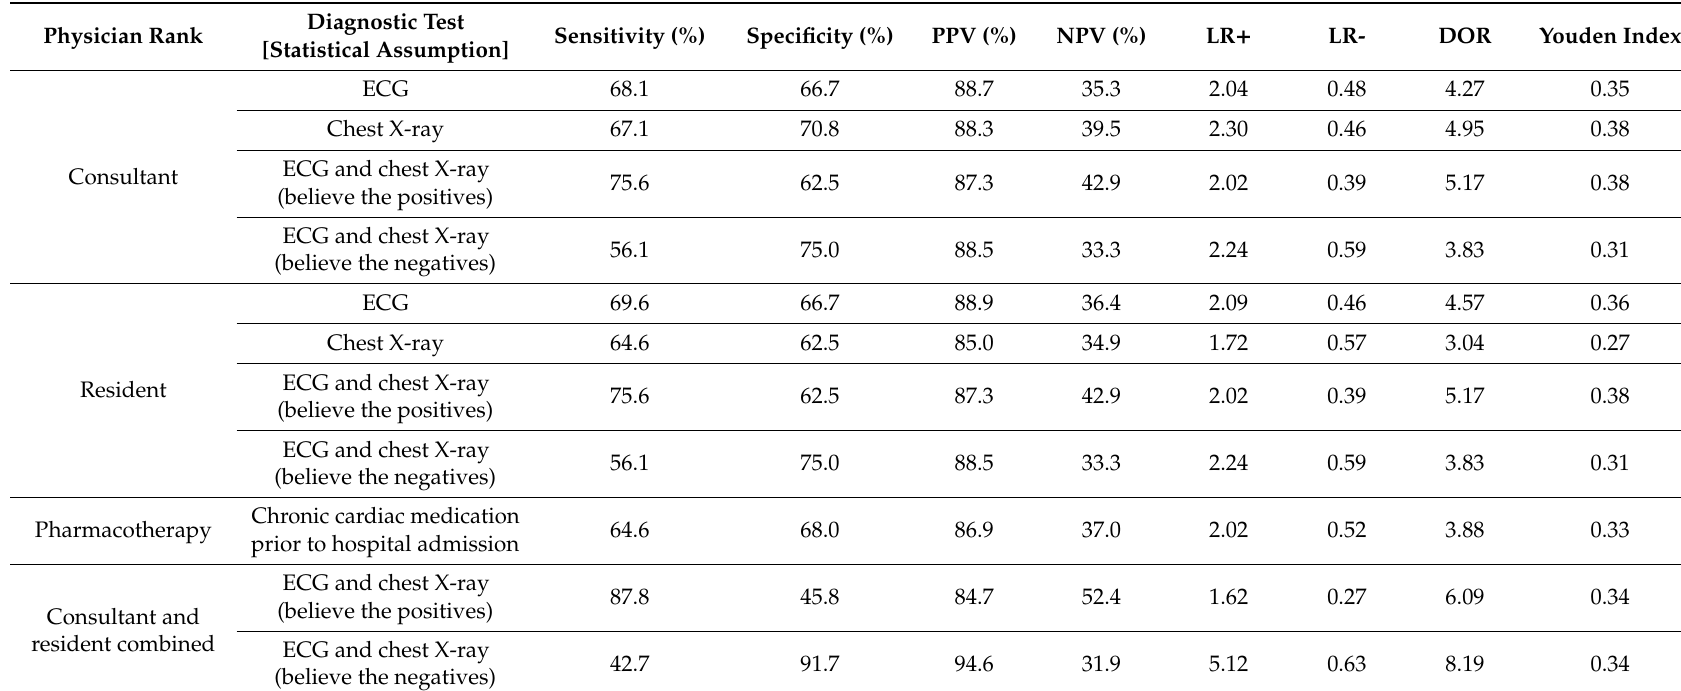
Table 5. Electrocardiogram (ECG) and chest X-ray